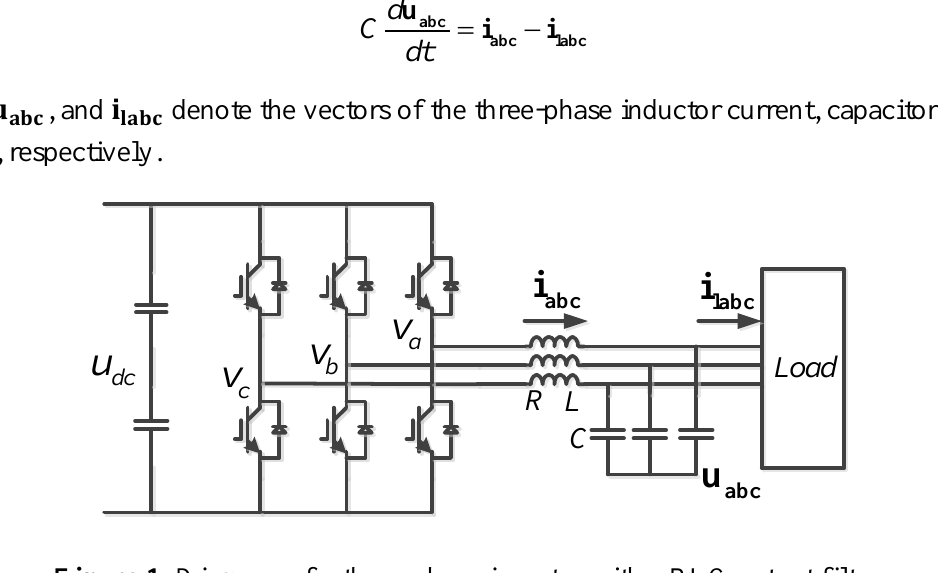
Figure 1. Diagram of a three-phase inverter with a RLC output